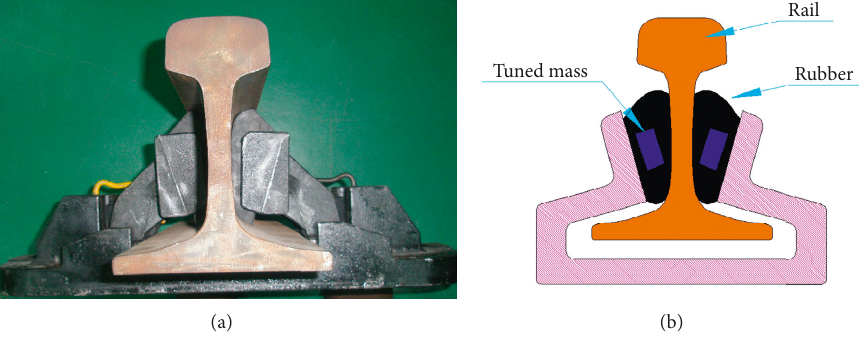
Figure 4: Structure of the floating rail